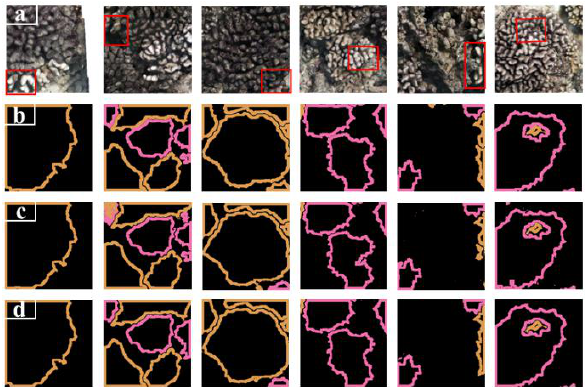
Figure 10 . Comparison of our boundary results on the test set. (a) original coral reef images, (b) ground truth, (c) U-Net, (d)